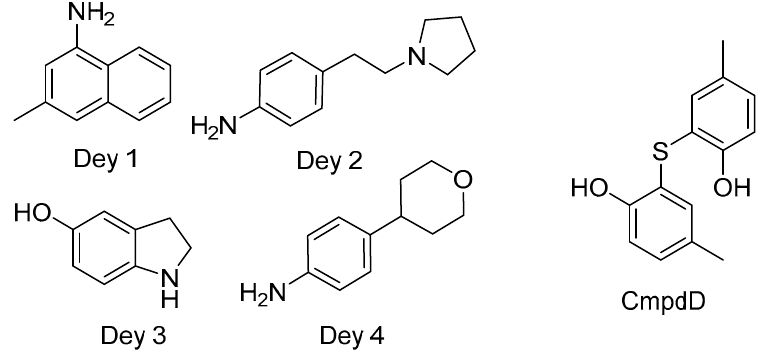
Figure 6. Structures of Dey 1-4 and CmpdD.